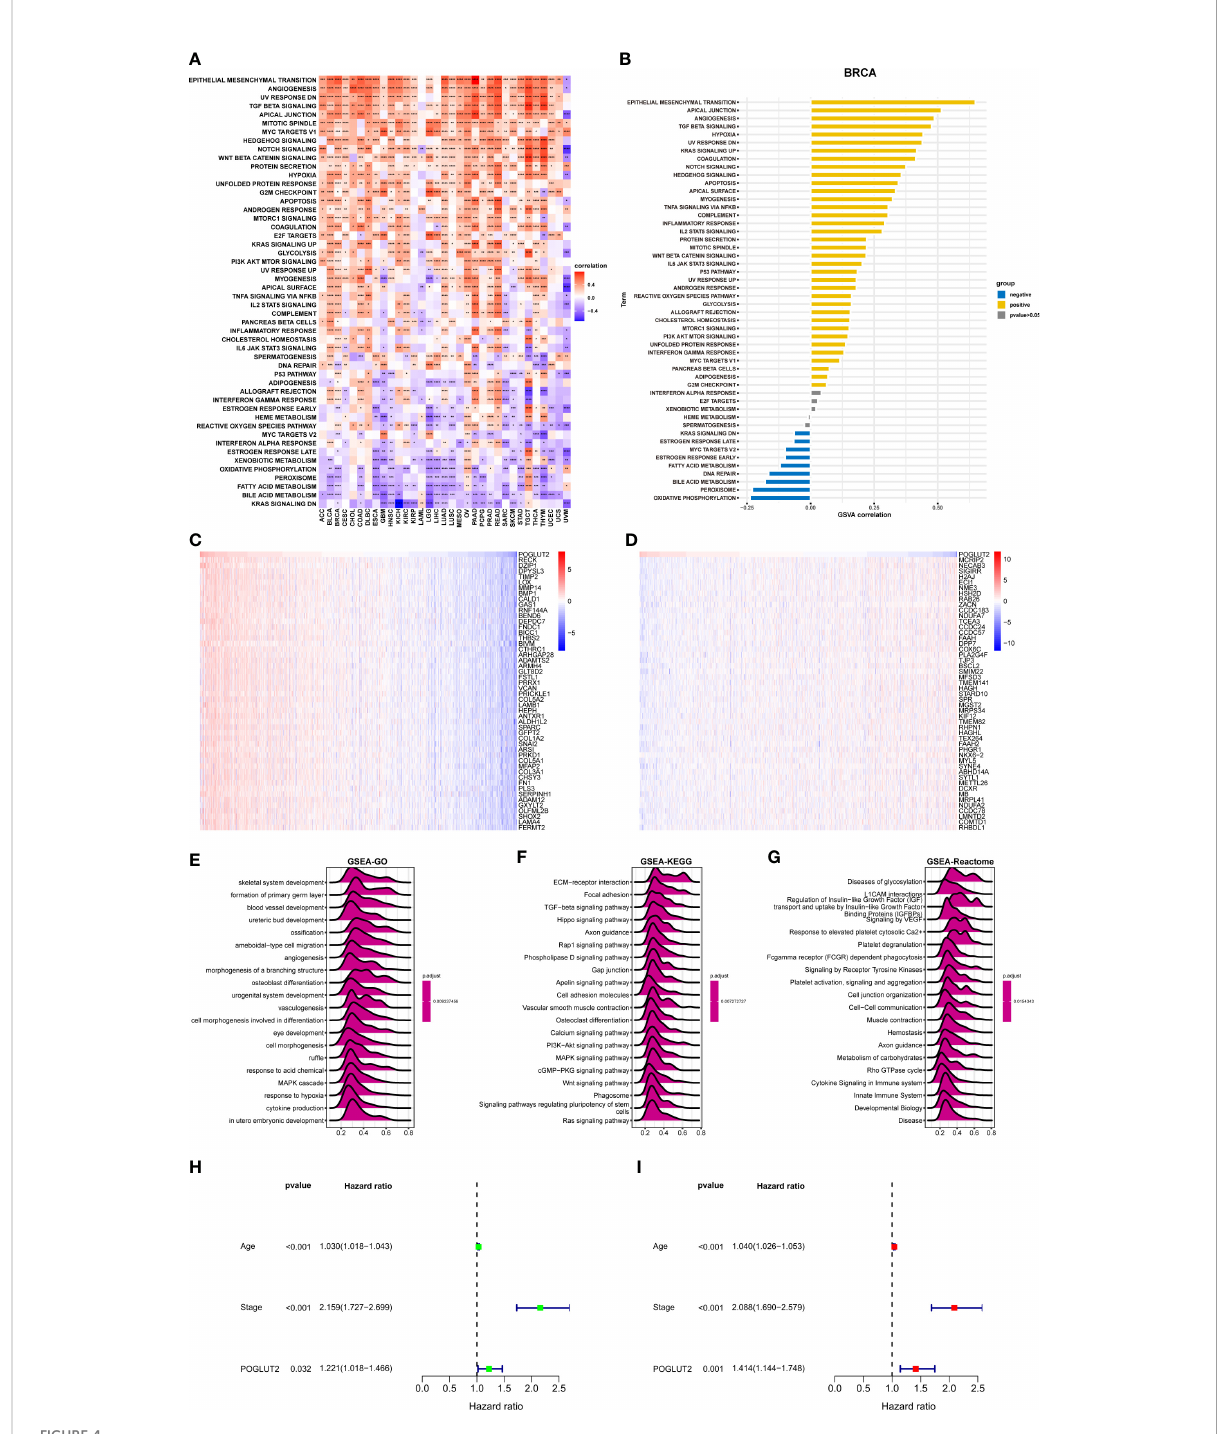
FIGURE 4 GSVA enrichment analysis. (A) . Top 50 POGLUT2 correlated hallmark pathways in pan-cancer. (B) Top 50 POGLUT2 correlated hallmark pathways in breast cancer. (C) Heatmap of top 50 positively correlated genes. (D) Heatmap of top 50 negative correlated genes. (E) GSEA-GO. (F) GSEA KEGG. (G) GSEA Reactome enrichment analysis using the correlation genes. Top 20 results were illustrated. (H, I) Univariate (H) and multivariate (I) Cox regression analyses assessing the prognostic value of POGLUT2 in breast cancer. GSVA, Gene Set Variation Analysis; GSEA, Gene Set Enrichment Analysis; KEGG, Kyoto Encyclopedia of Genes and